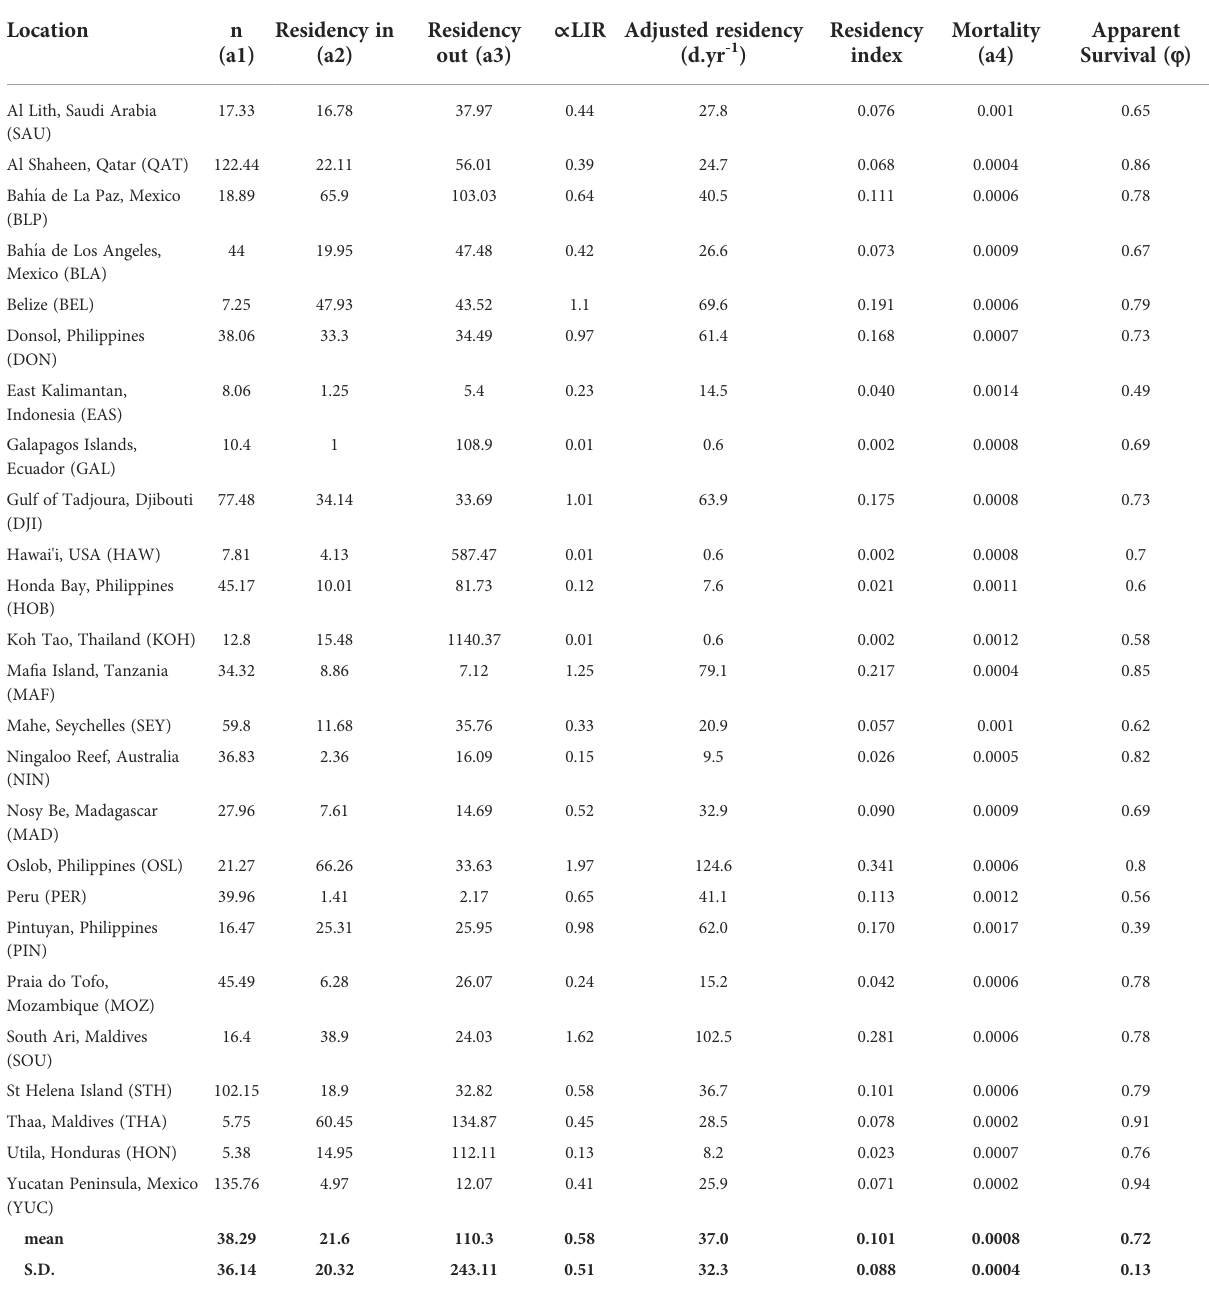
TABLE 3 Model H outputs ( Table 3 ) for all sites analysed and general aggregation attributes.